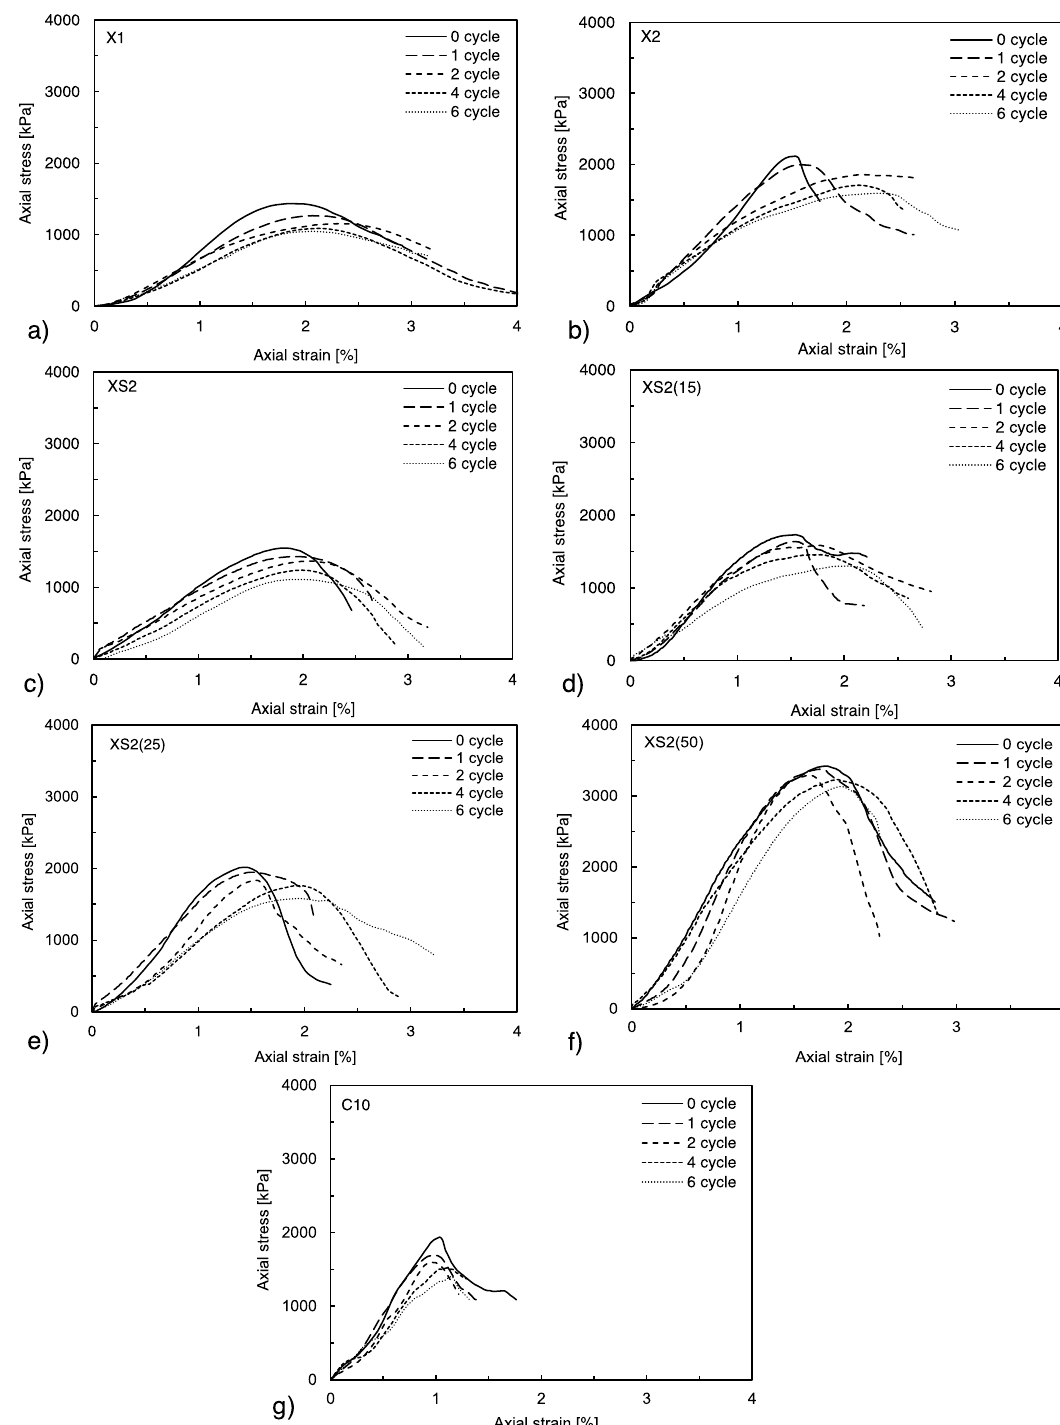
Figure 11. Stress–strain curves after cyclic F–T (1–6 cycles) of ( a ) X1, ( b ) X2, ( c ) XS2, ( d ) XS2(15), ( e ) XS2(25), ( f ) XS2(50), and ( g )